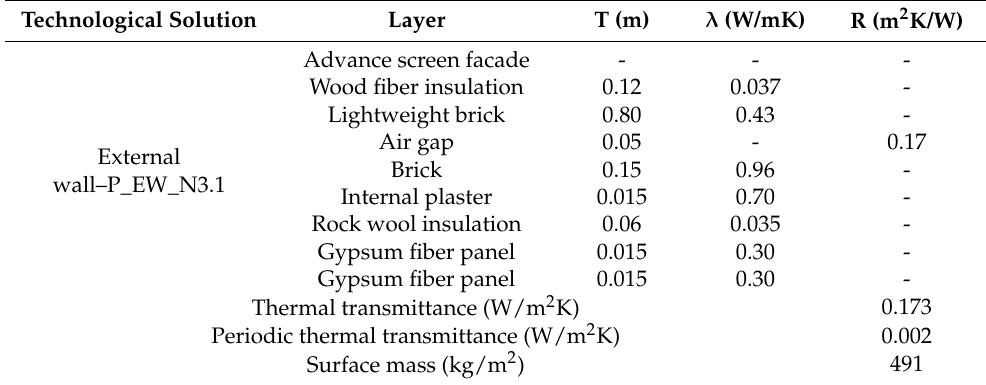
Table A9. Possible upgrade measure of external wall stratigraphy (P_EW_N3.1) with the same technological solution of P_EW_N1.1 but with wood fiber insulation.